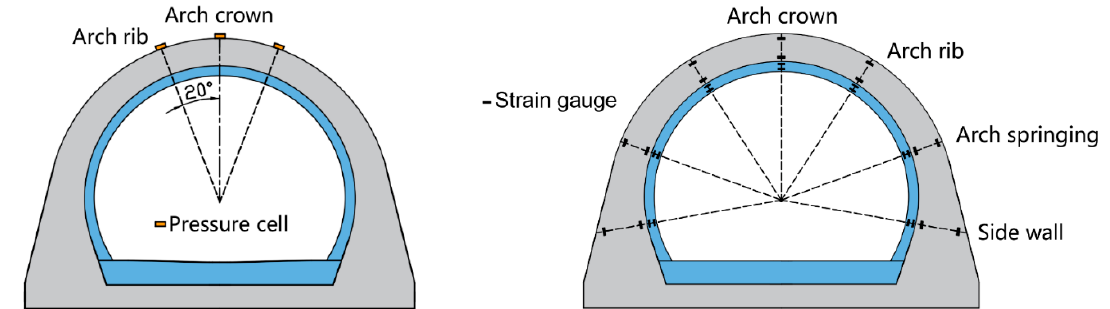
Figure 10. The layout of pressure cells and strain gauges.